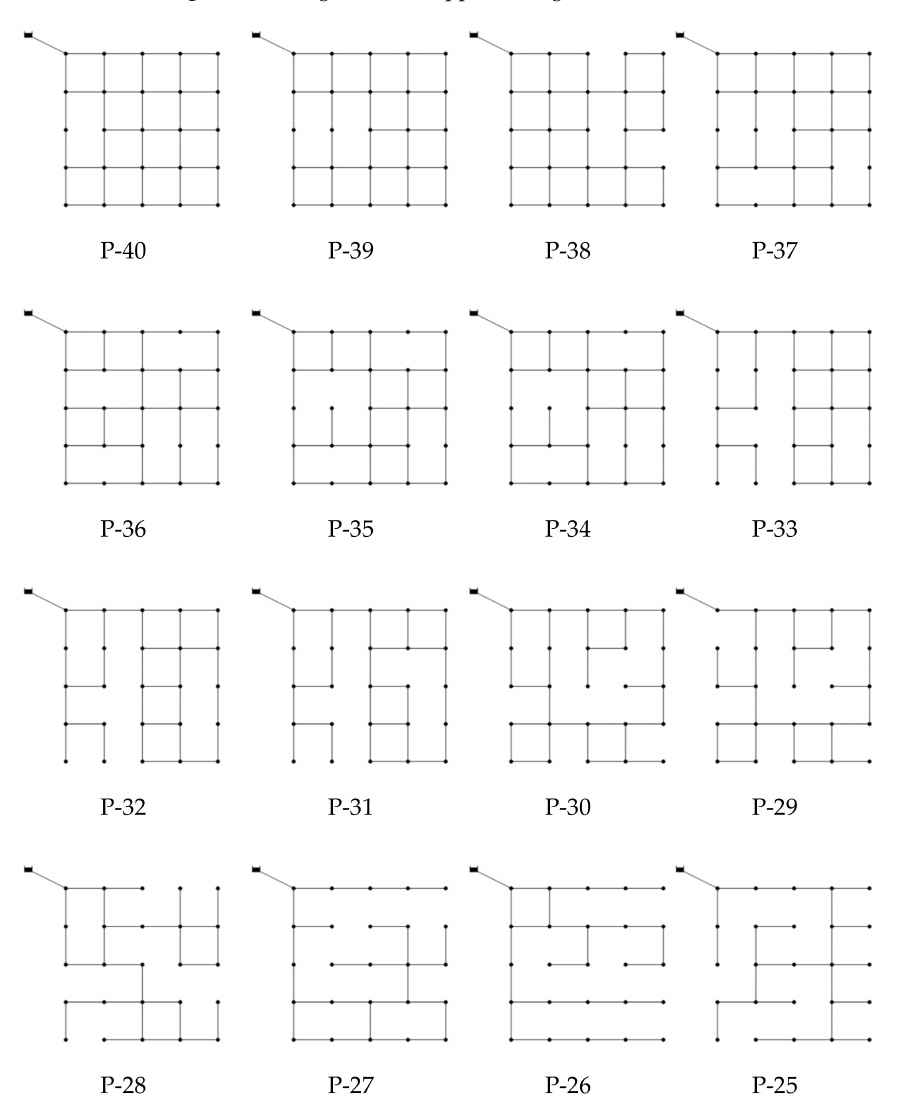
Figure 3. Optimally designed application network